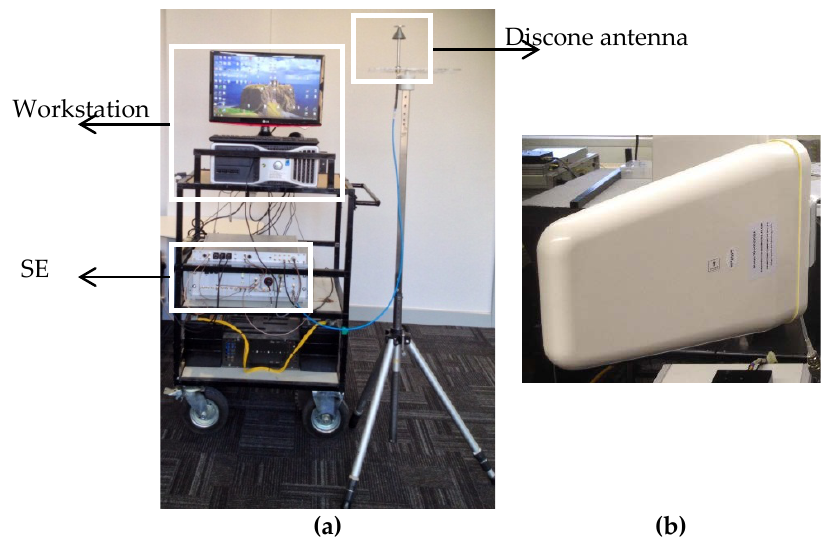
Figure 2. Measurement setup: ( a ) discone antenna, ( b ) log periodic antenna .